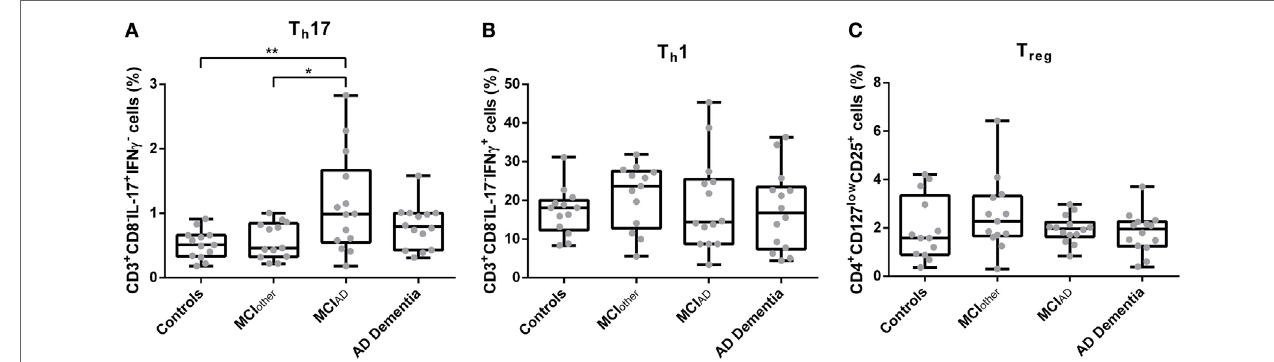
FigUre 1 | Percentages of CD3 + CD8 − IL-17 + IFN γ − T h 17 cells (a) , CD3 + CD8 − IL-17 − IFN γ + T h 1 cells (B) , and CD4 + CD127 low CD25 + T regs (c) as assessed with flow cytometry from donor derived cryopreserved peripheral blood mononuclear cells were compared between controls, mild cognitive impairment (MCI) other , MCI AD , and Alzheimer’s disease (AD) dementia. Data are summarized as combined box- and scatter plots ( p -values from post hoc tests are shown * p < 0.05, ** p <